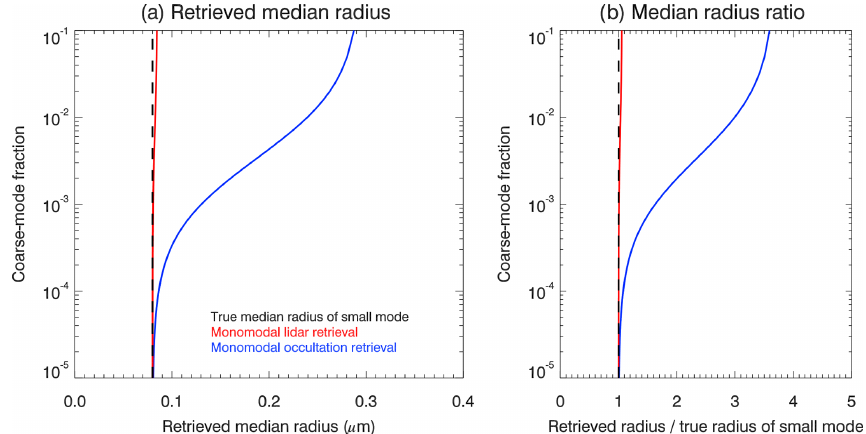
Figure 3. (a) The coarse-mode fraction dependence of retrieved stratospheric-aerosol median radius r m is shown for an assumed monomodal log-normal particle size distribution with S = 1 . 4 based on simulated lidar (red line) and satellite occultation (blue line) measurements. The actual aerosol particle size distribution is a bimodal log-normal distribution. The black dashed line corresponds to the true median radius of the small mode. Note that the distribution width of the monomodal distribution assumed for the retrievals was chosen to be identical to the width of the main mode of the bimodal log-normal distribution used for the forward simulations. For the smallest coarse-mode fractions, the median radius of the small mode can be well retrieved for all measurement geometries, as expected. (b) Ratio of the retrieved radii and the true median radius of the small mode of the bimodal log-normal